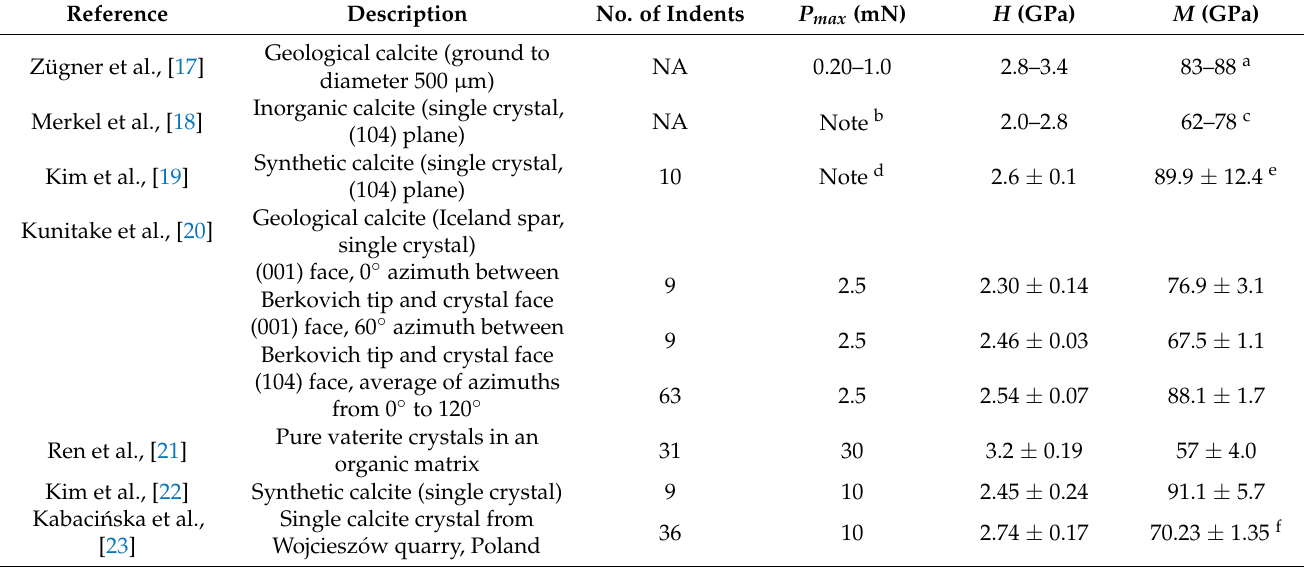
Table 2. Indentation properties of calcium carbonate reported in the literature.